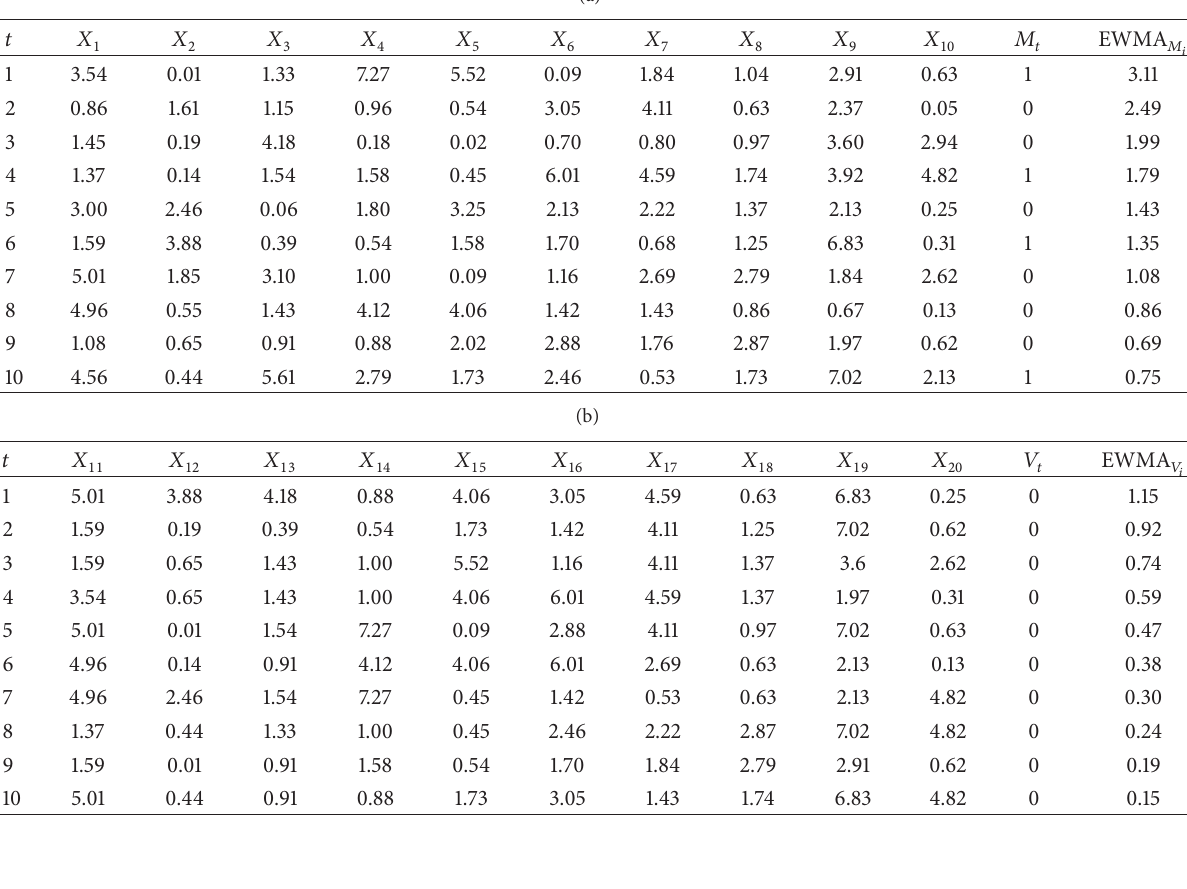
Table 15: (a) The new service times from the first ten counters in a bank branch ( 𝜆 1 = 𝜆 2 = 0.2 ). (b) The new service times from the last ten counters in a bank branch ( 𝜆 1 = 𝜆 2 = 0.2 ).